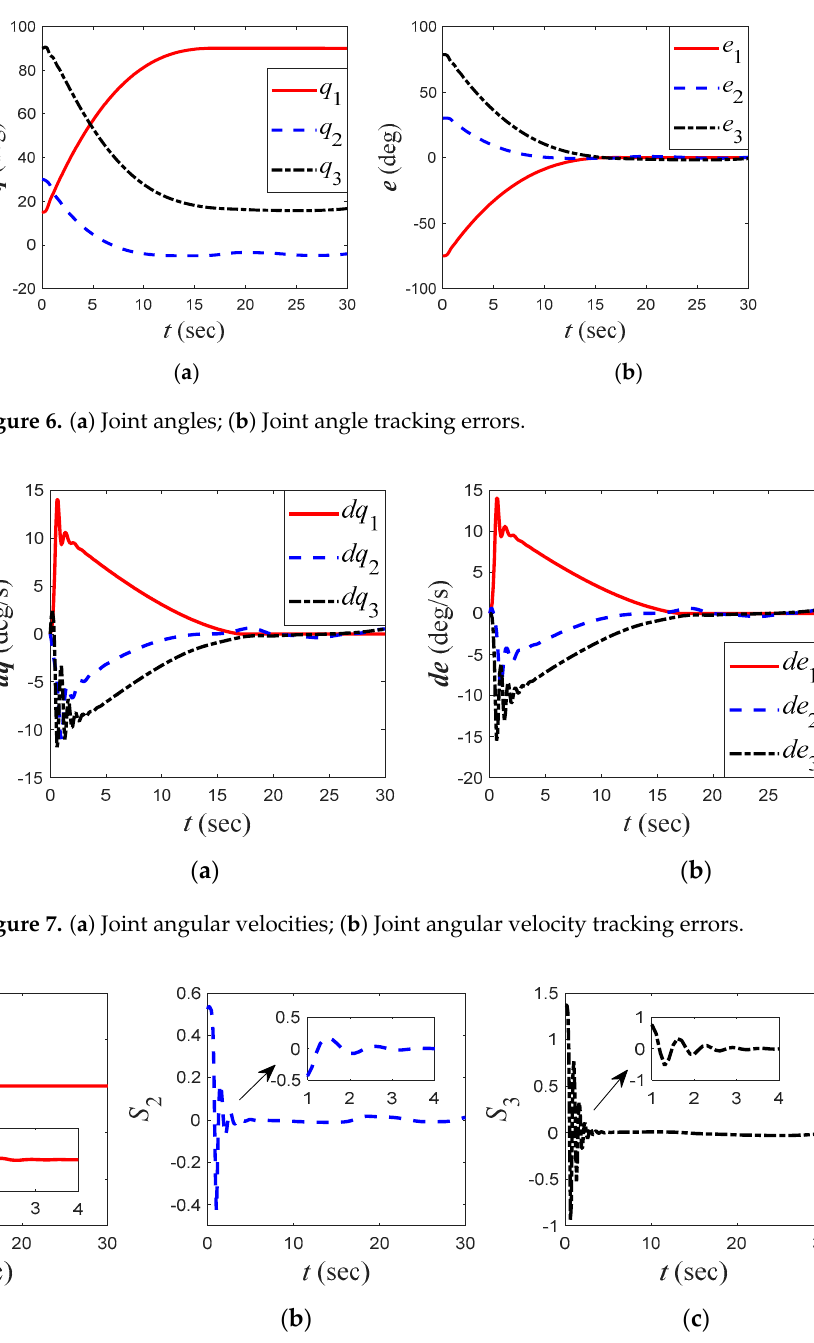
Figure 8. ( a ) The first value of the sliding manifold; ( b ) The second value of the sliding manifold; ( c ) The third value of the sliding manifold.